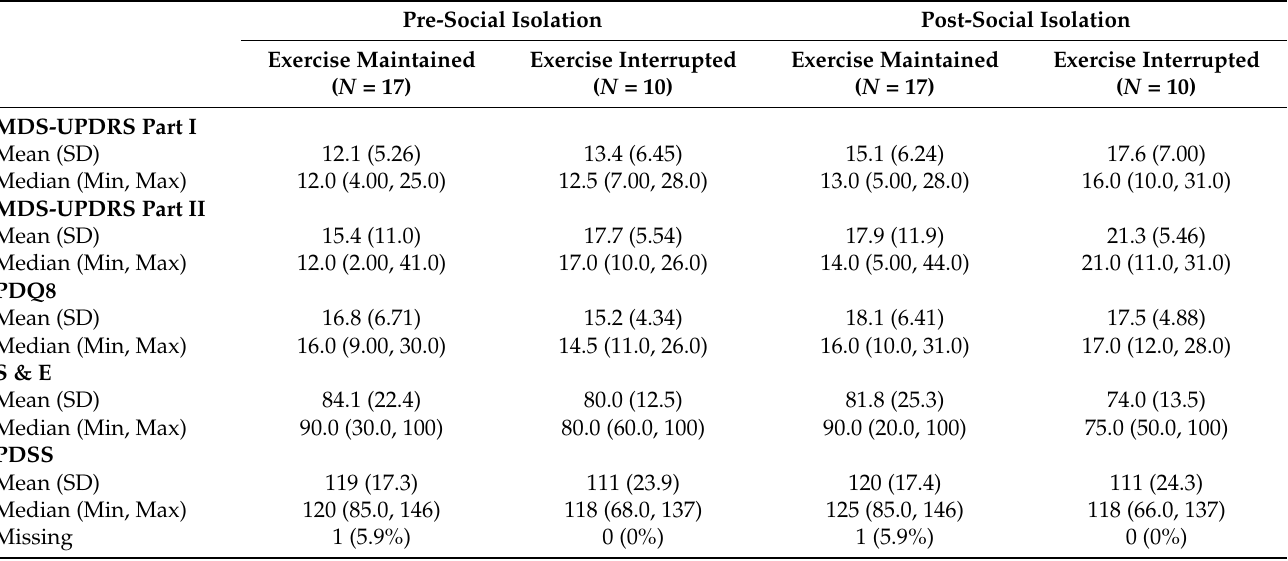
Table 2. Clinical characteristics of Parkinson’s disease patients in pre- and post-assessment moments in terms of function of exercise